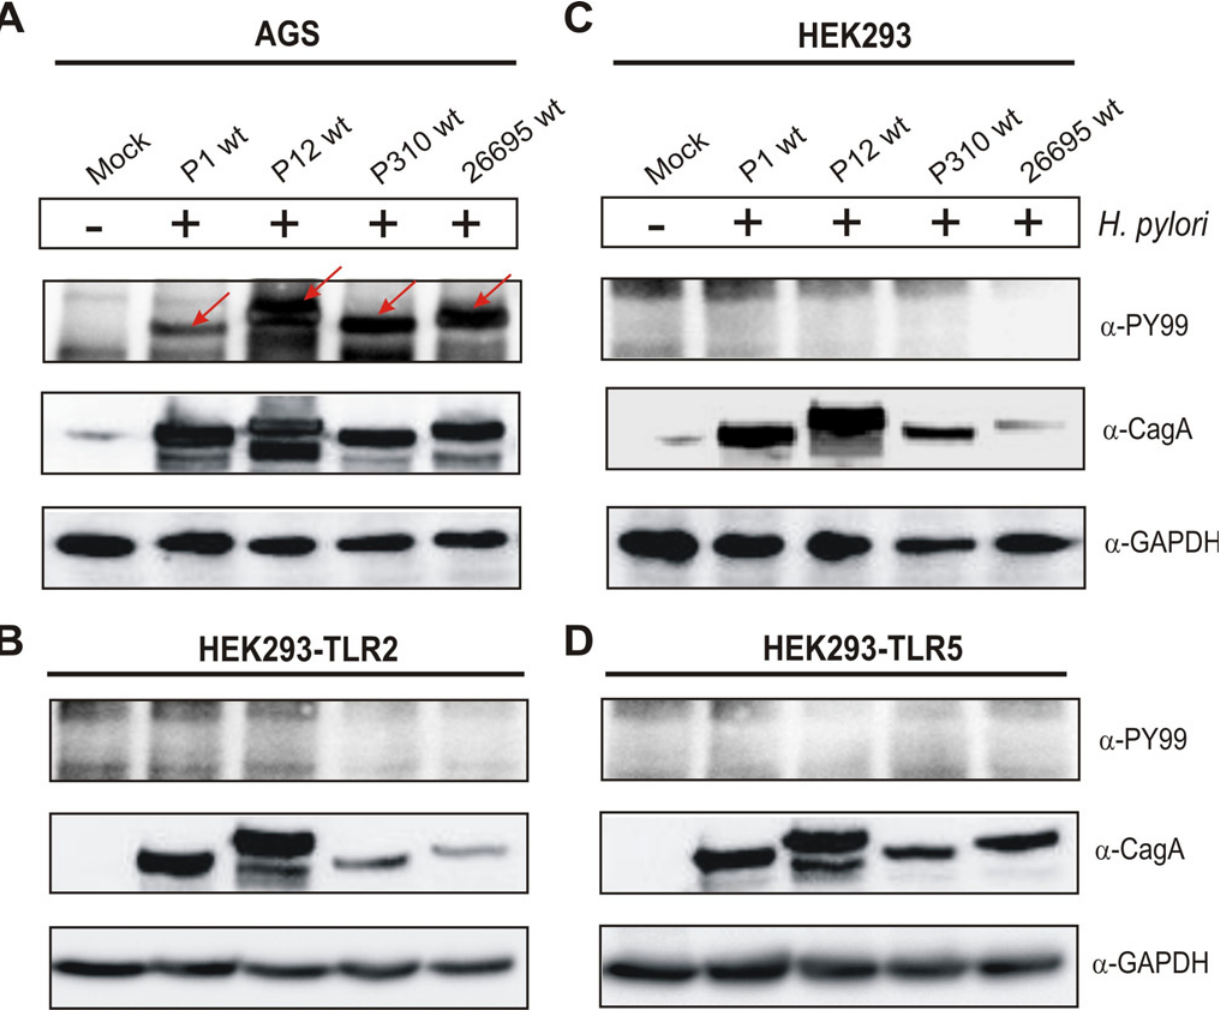
Fig 3. CagA injection by H. pylori cannot be achieved in infected HEK293 cell lines but in AGS gastric epithelial cells. Western blot analysis of (A) AGS, (B) HEK293-TLR2, (C) HEK293 and (D) HEK293-TLR5 cells infected with H. pylori wild-type strains P1, P12, P310 or 26695 for 6